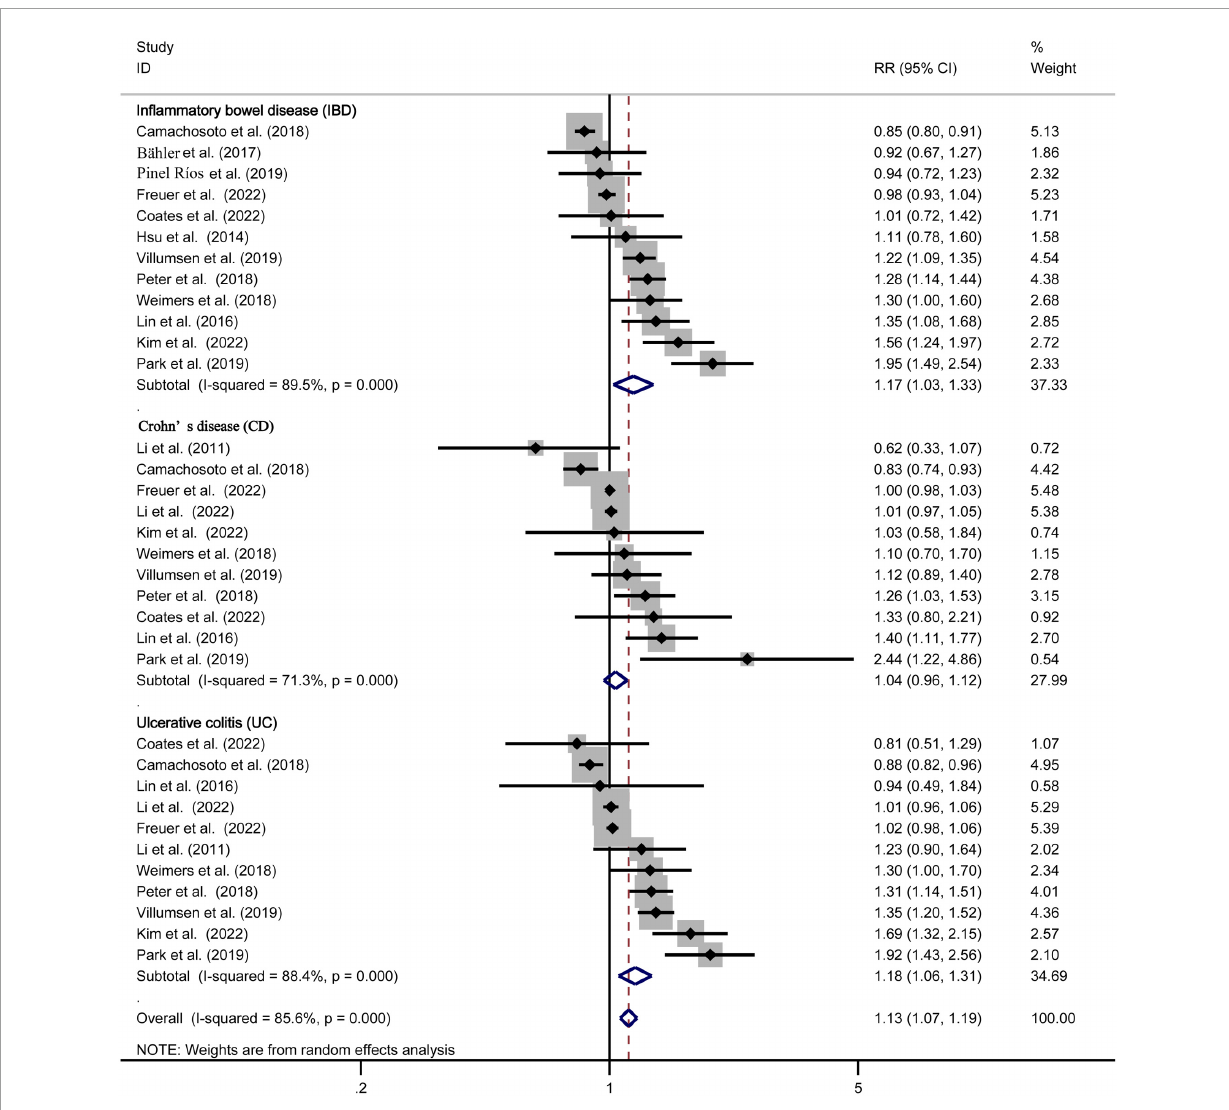
FIGURE2 Forest plot of the Parkinson’s disease risk in patients with inflammatory bowel disease, Crohn’s disease, and ulcerative colitis.